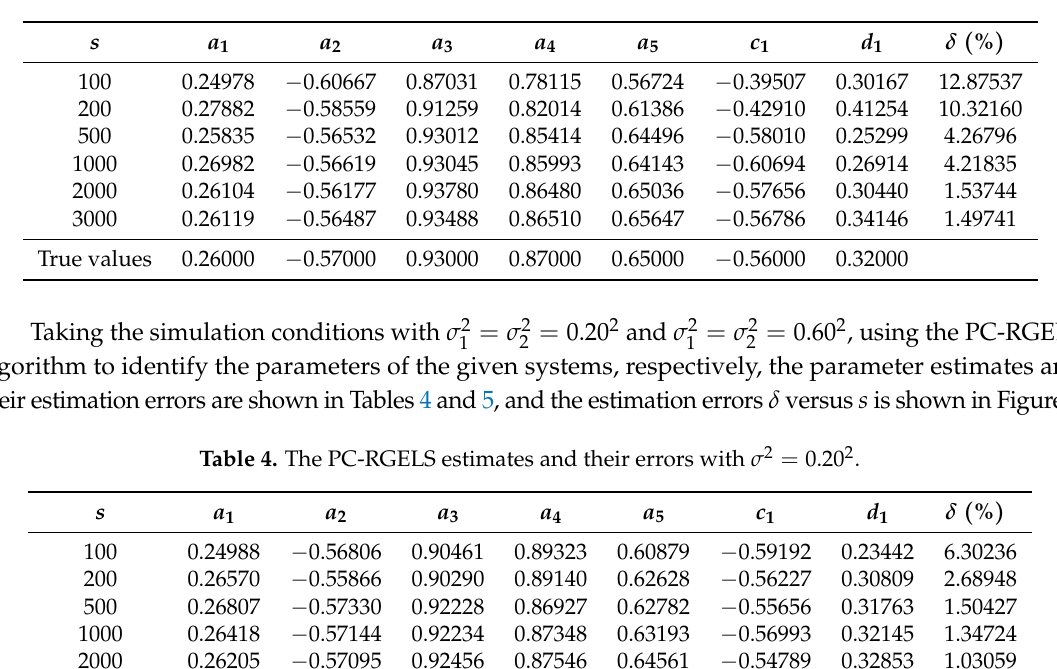
Table 3. The PC-RGELS estimates and their errors.